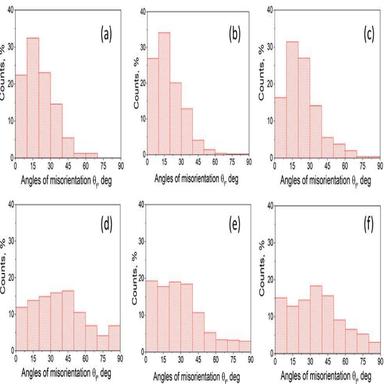
The distributions of the angles of misorientation between adjacent QC – (a–c) and TC – (d–f) facets on the fracture surfaces of the technically pure iron – (a, d), Fe-2.5%Si alloy – (b, e) and low-carbon steel S235JR – (c, f) specimens.